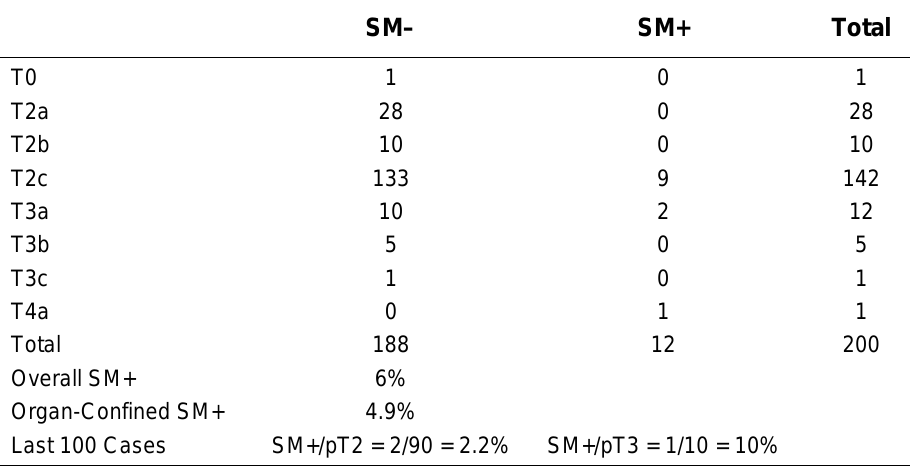
Pathological Margin Data for 200 Consecutive Robotic Cases